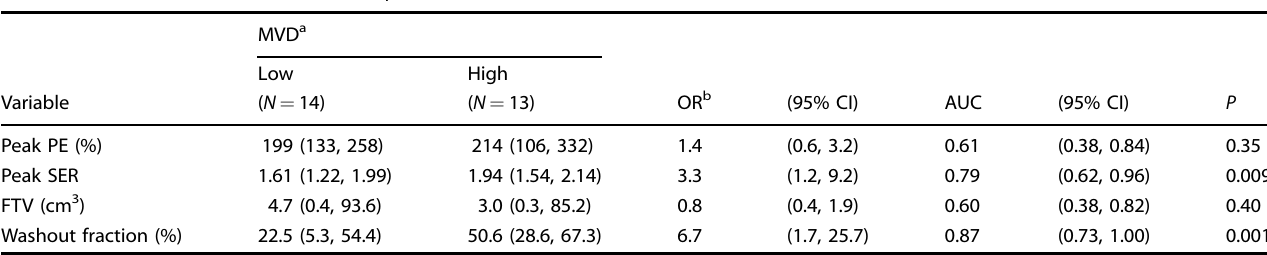
Table 2. Univariable associations of kinetic parameters with MVD.